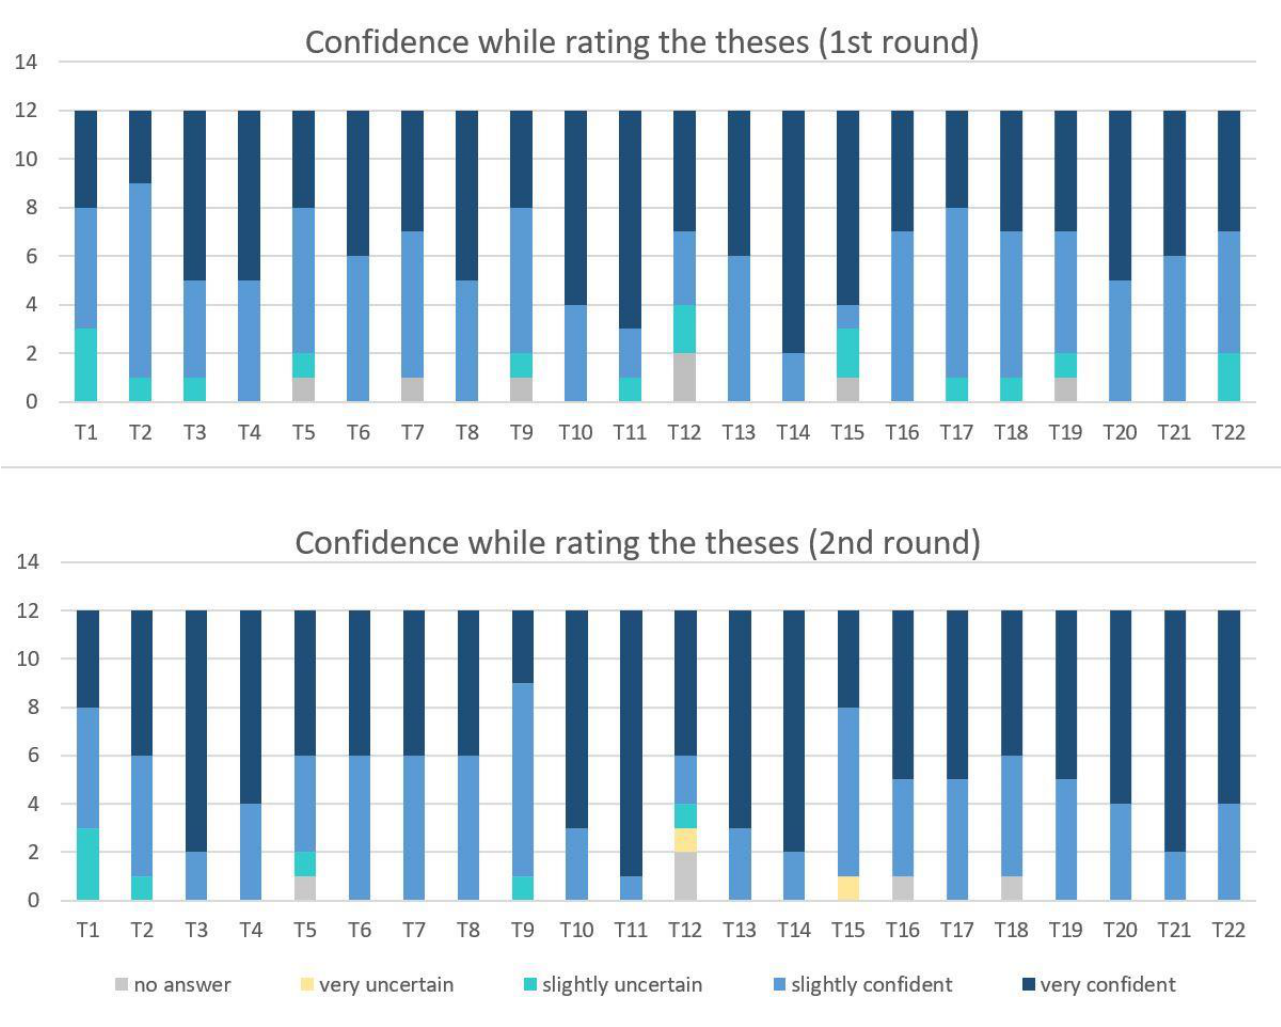
Figure 4. Confidence while rating the theses in the first and second